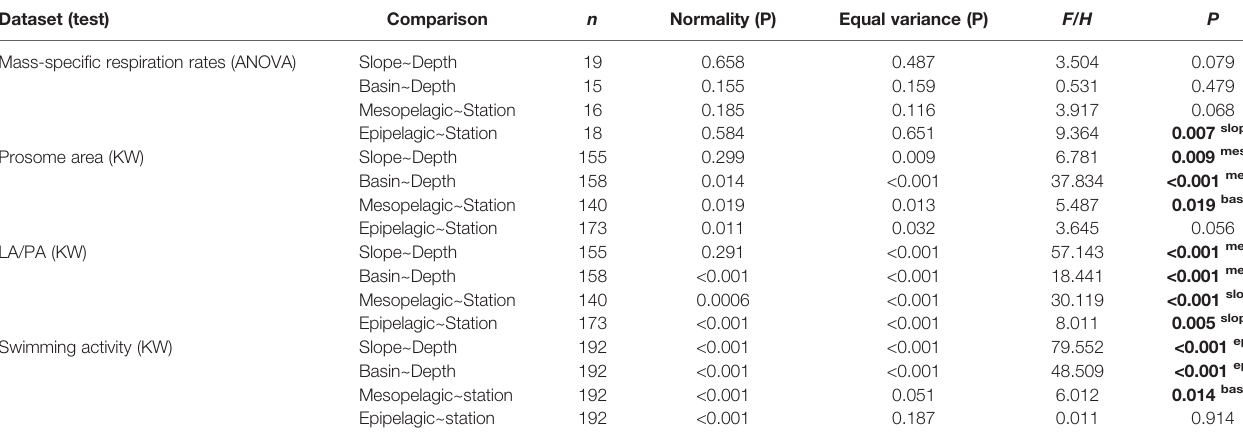
TABLE 1 | Statistical comparison of each diapause indicator between stations (slope D6 and basin F7) and depths (epi- and meso-pelagic). Dataset